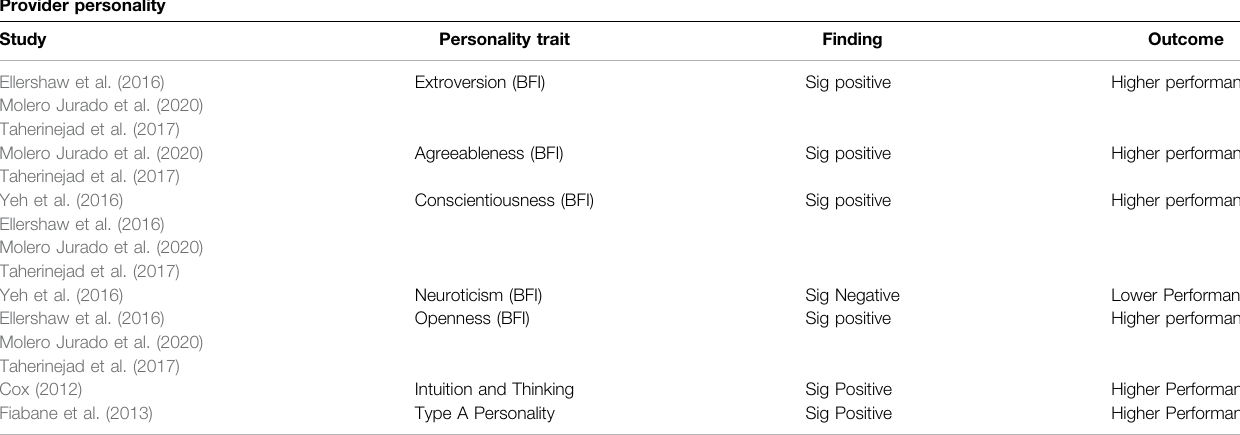
TABLE 3 | Summary of provider ’ s personality traits on related